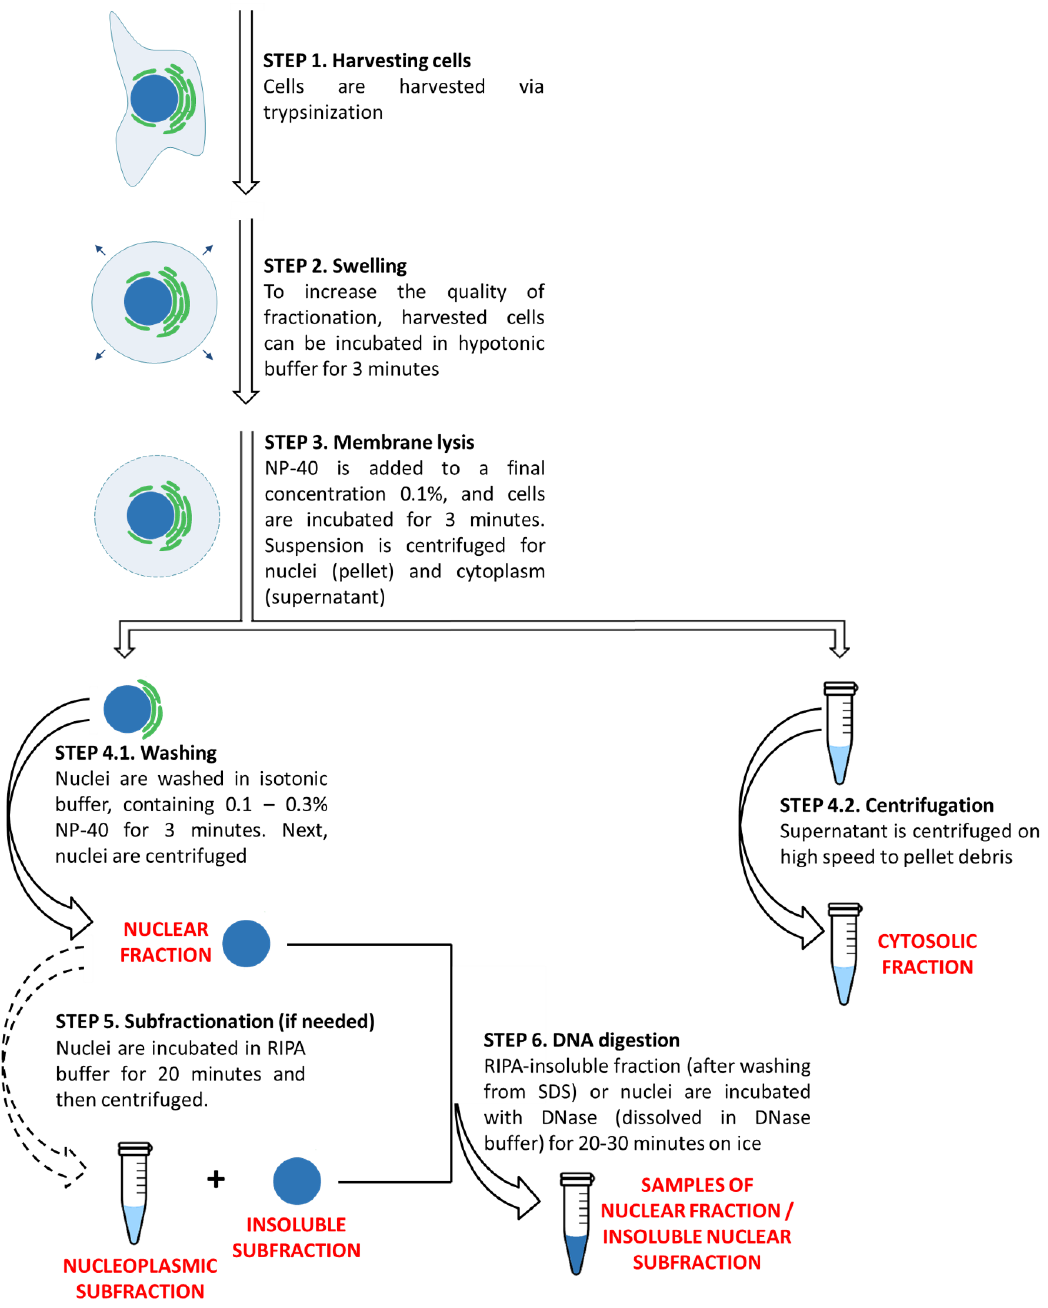
Figure 5. Graphical representation of the nucleus/cytoplasm fractionation protocol.